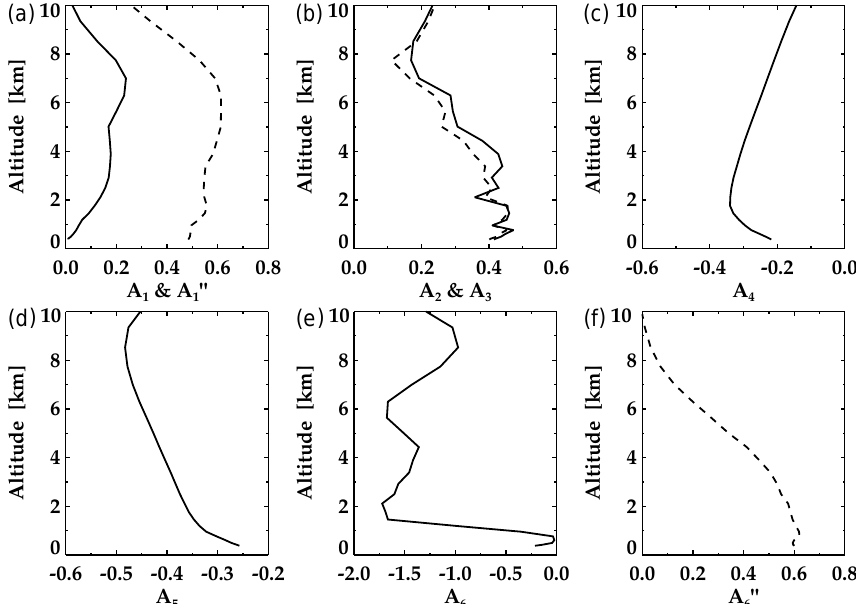
Figure 5. Sensitivity coefficients A (cid:48)(cid:48) between OH and each perturbation variable: In the calculation, multi-annual mean relative differences i in OH and in the forcing are ratioed. (a) Sensitivity of OH to changes in O 3 levels (kinetics effect) denoted by A 1 (solid line) and to changes in j due to changes in O 3 (photolysis effect) denoted by A (cid:48)(cid:48) (dashed line); (b) sensitivity of OH to changes in radiosonde – NIWA–UKCA O 1 D 1 CCM H 2 O ( A 2 solid line) and to changes in ERAI – NIWA–UKCA H 2 O ( A 3 dashed line); (c) sensitivity of OH to changes in CH 4 ( A 4 ); (d) sensitivity of OH to changes in CO ( A 5 ); (e) sensitivity of OH to changes in temperature (kinetics effect) denoted by A 6 ; (f) sensitivity of OH to changes in j due to changes in temperature (photolysis effect) denoted by A (cid:48)(cid:48) O 1 D 6